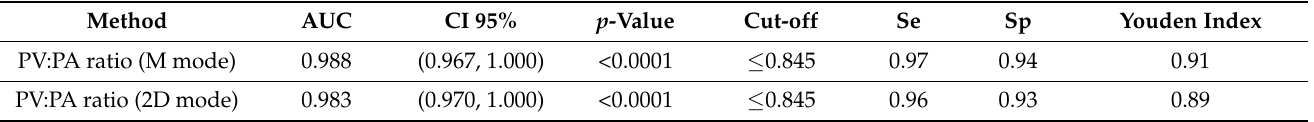
Table 3. Sensitivity, specificity, and Youden index of cut-off points of PV:PA for predicting